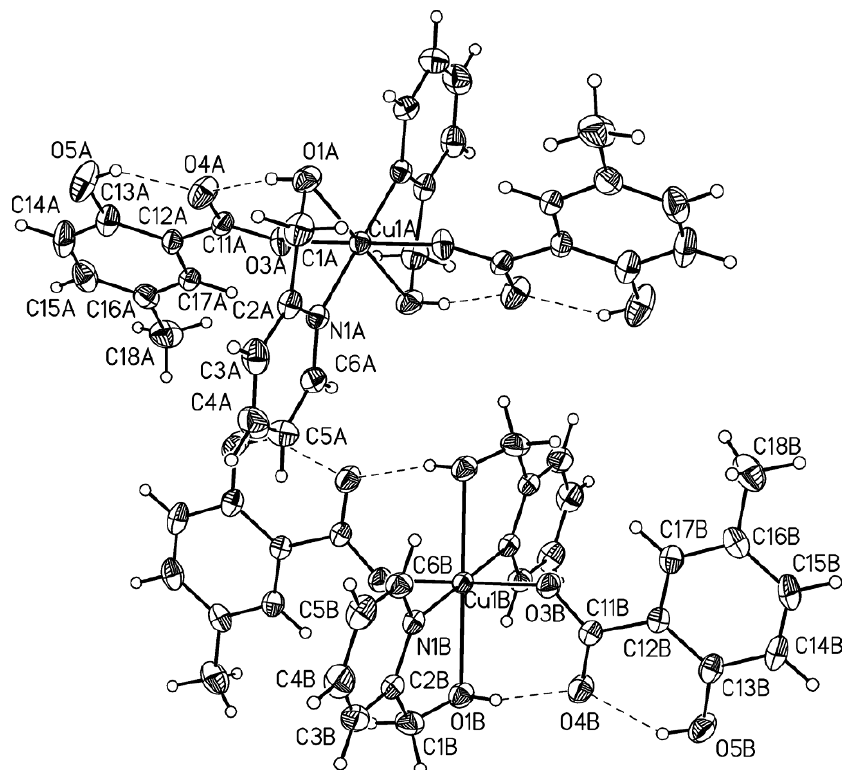
Figure 3. View of [Cu(5-Mesal)